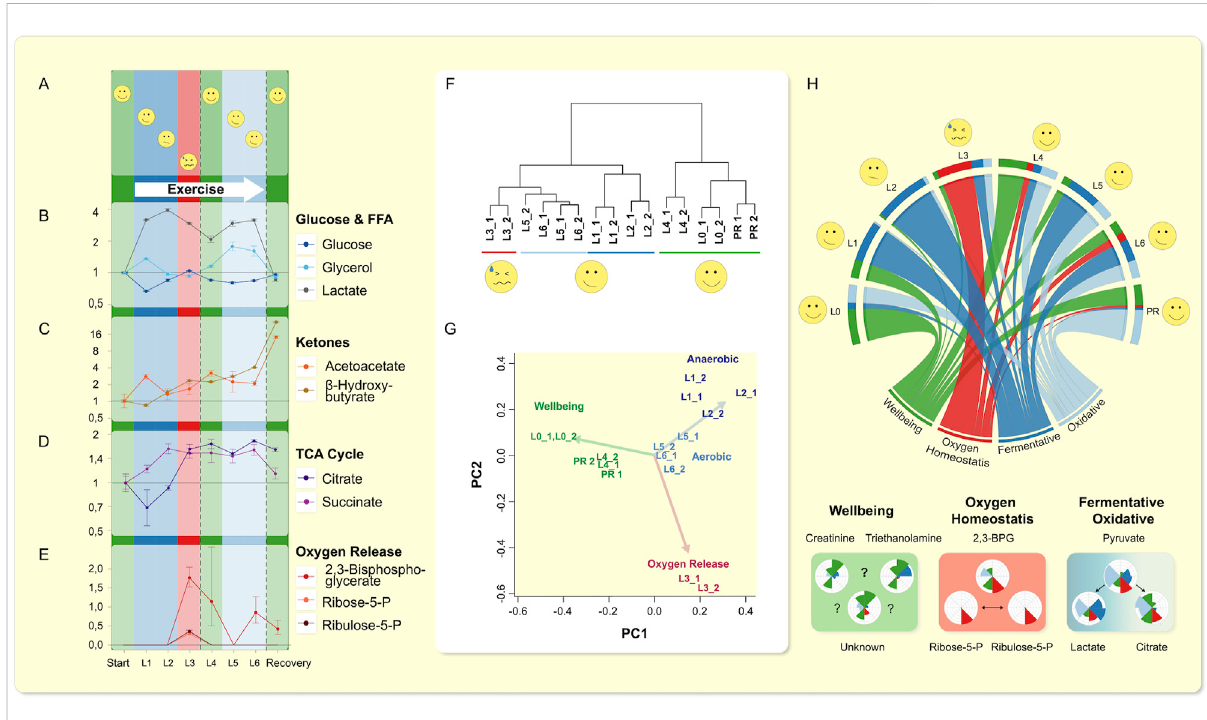
FIGURE 1 Single drop-blood analysis from an exerciser. (A – E) The rating of perceived exercise (RPE) variable is displayed as a subjective scale. Lactate (as opposed to glucose) increases similar to TCA-intermediates (Supplemental Figure S14), except for citrate. (D) Citrate only increased when oxygen release was promoted as indicated by rise of 2,3-BPG and PPP-intermediates Ribulose-5P and Ribose-5P above LOQ. (E) Glycerol showed two phases (corroborated by fatty acids, Supplementary Figure S15) of release and reaches baseline value, while (B) ketone bodies accumulate. (F) Hierarchicalclusteringofthetechnicalreplicatesthroughouttherunonmetabolicfeaturesisshown.Clustering,usingallpolarmetabolites,grouped thesamplingtime-pointsinaccordancewiththevolunteer ’ sself-perception.Lap3(L3),inwhichexhaustionoccurred,wasleastrelatedtobeginning recovery (PR), and the most at maximum RPE (L4, Lap 4), while these three timely very diverse laps were closest related. (G) Visualization of a nine- metabolite principle-component analysisfound byfactoranalysisrepresenting theexplanatory components of all data (relative activity ofanaerobic andTCAcycleactivity(pyruvate/lactatevs.pyruvate/citrate),oxygenrelease,andoxidativestress,aswellasmarkersof “ feelingenergetic ” areshown. These metabolites reproduced the principal relationships of metabolic states and transitions as observed within all data. (H) The visualization of the progression through the exercise regime is summarized in a circos plot (Krzywinski et al., 2009) using the nine explanatory metabolic features and relationshipsdepictedin NIGHTINGALE plotsbelow.The circos plotshowsprogressionofeachofthefourfactorsdeterminedin (G) ,bothforeachfactor (lower “ root ” ) and through each lap (start at left “ L0 ” ). The NIGHTINGALE plots below show the progression of the nine key metabolites (see main text). Beginning at rest, the subject entered an initial anaerobic phase, which was followed by an energy crisis caused by insuf fi cient oxygen availability. Resolution in Lap 4 was accompanied by a transient increase in indicators of feeling “ energetic ” (i.e. low RPE) and immediately followed the successful transition to oxidative TCA cycle driven energy supply that remained elevated until after exercise